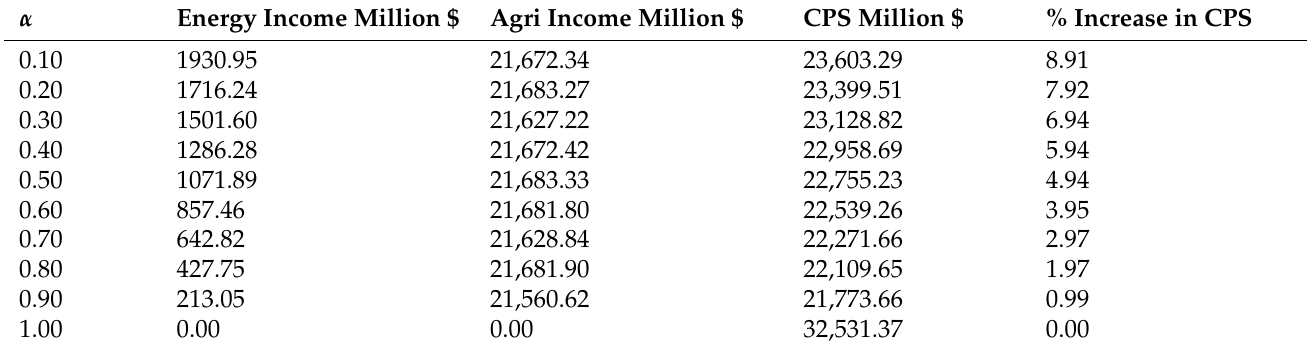
Table 4. Impact of hydropower on basin wide income with 80% exceedance probability.